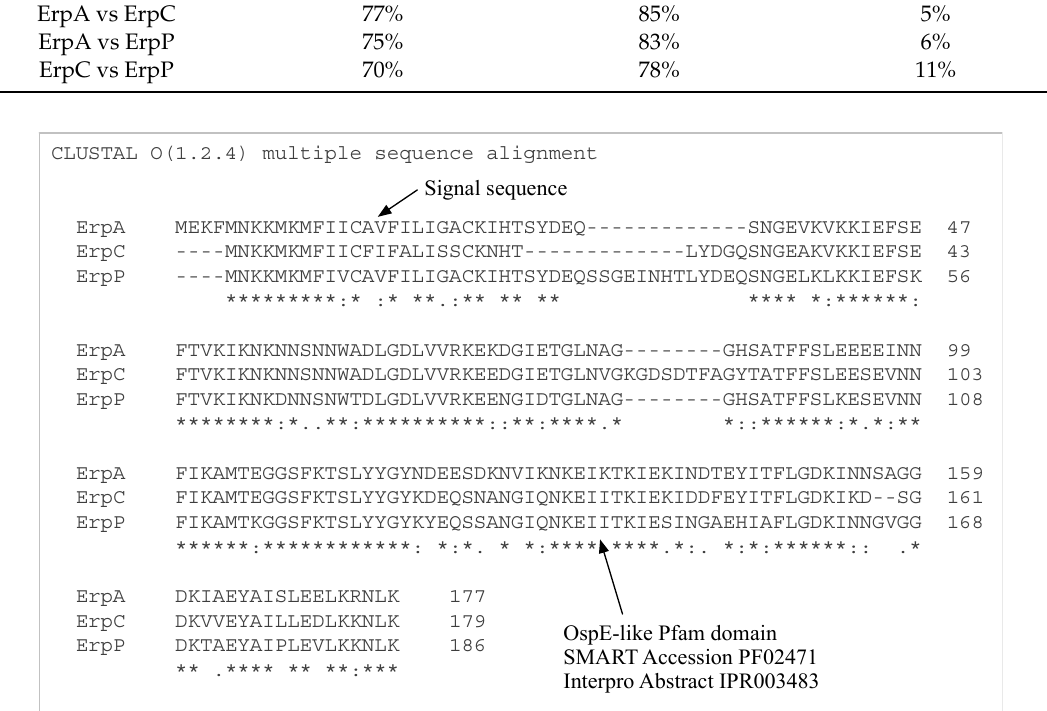
Table 3. Clustal Omega (version 1.2.4) alignment identity, similarity and gaps for Erp amino acid sequences.